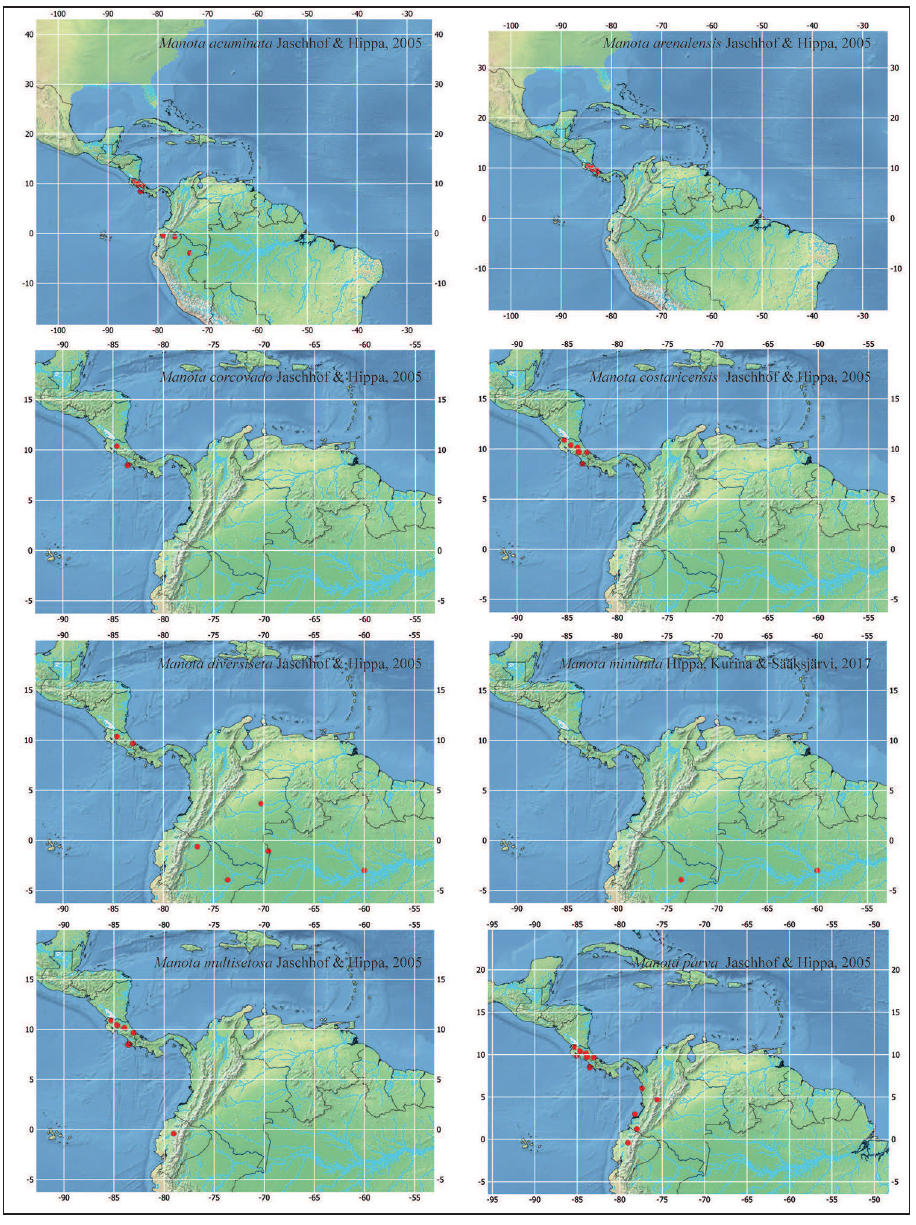
Figure 7. Distribution of described Manota species recorded in this paper. Amazon basin elements, connects to that of Central America. For some groups, as e.g. monkeys and some sciarids, as Rhynchosciara (Amorim and Pires 1996), the patterns refer to species restricted to smaller areas in lowlands on both sides of the Andes, Cen- tral America and Mexico, as well as in the Brazilian